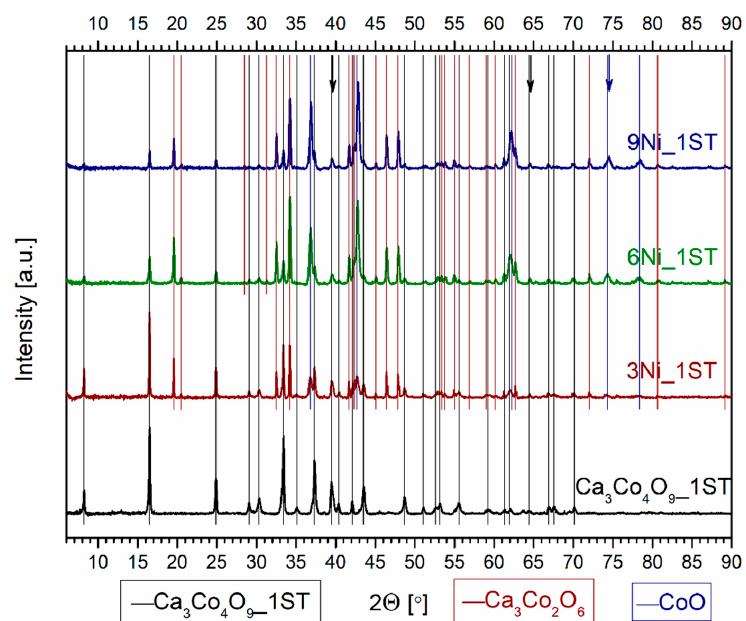
Figure 2. Normalized XRD patterns of the 1ST sintered reference matrix and Ni added samples. The vertical lines of different colors mark the main identified phases. The arrows mark the peak displacements of the phases suggesting substitution with Ni, namely Ca 3 Co 4 O 9 (black arrows) and CoO (blue arrow).